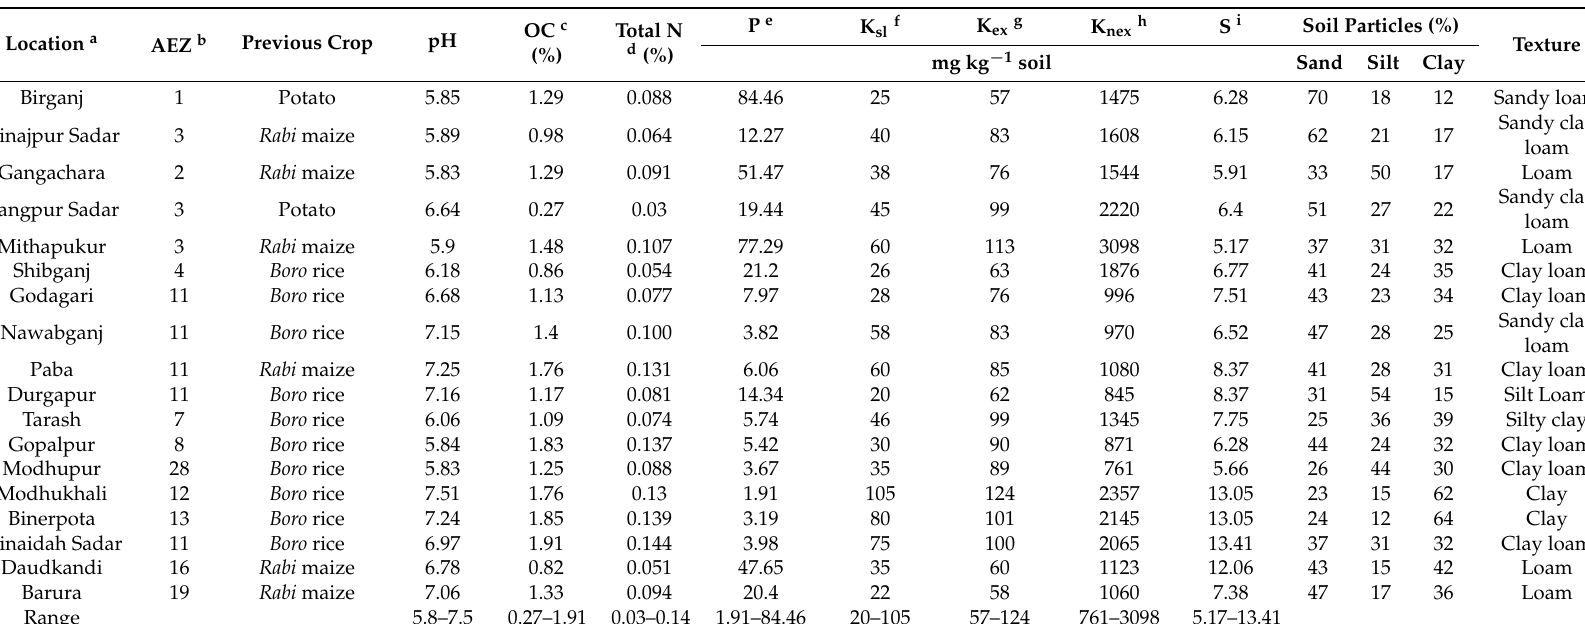
Table 1. Basic chemical and physical properties of 18 soils (0–15 cm), collected from various locations, used for pot experiment with maize at Bangladesh Rice Research Institute (BRRI) net house in Gazipur, Bangladesh, 2011–2013.